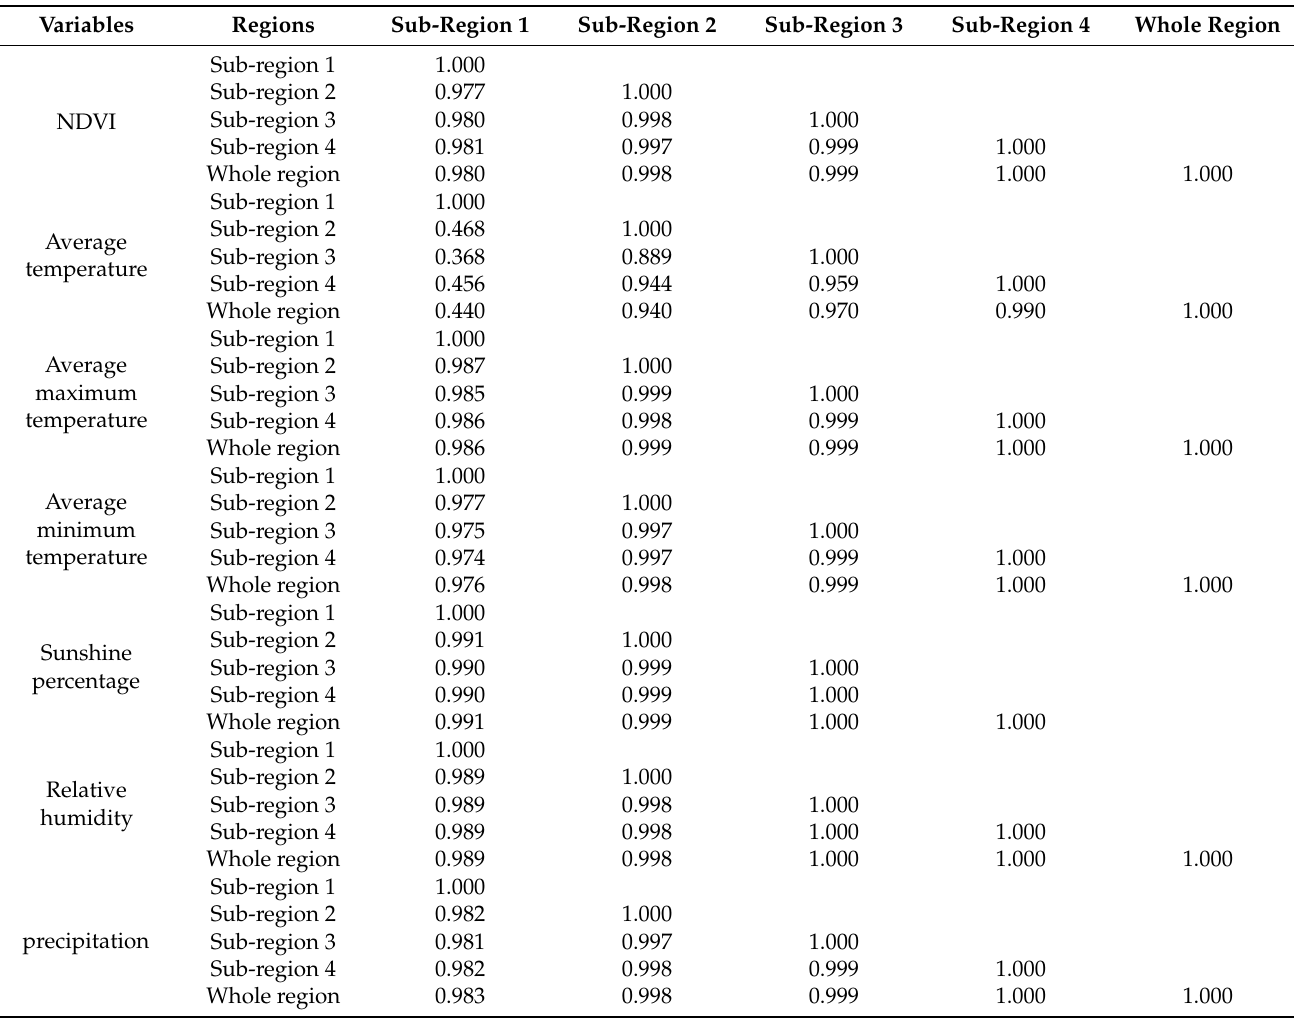
Table 3. Pearson correlation coefficients between the regional average variables of the five regions (four sub-regions and the whole region) in June during the study